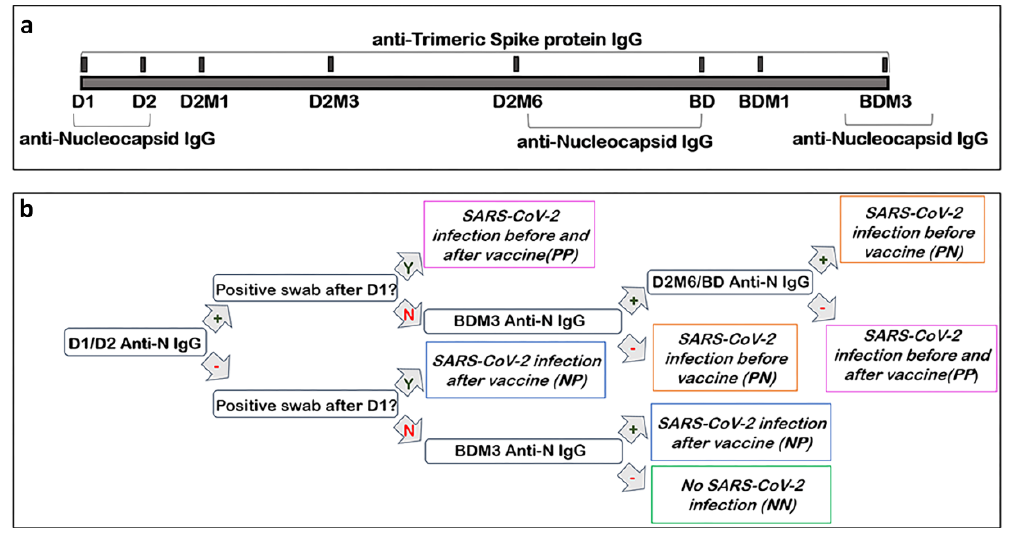
Figure 1. Illustration of study design: ( a ) timeline and methods; and ( b ) schematic representation of the methods used to determine the SARS-CoV-2 infection group allocation. D1, dose 1; D2, dose 2; D2M1, 1 month after dose 2; D2M3, 3 months after dose 2; D2M6, 6 months after dose 2; BD, booster dose; BDM1, 1 month after booster dose; BDM3, 3 months after booster dose; SARS-CoV-2, severe acute respiratory syndrome-coronavirus-2; anti-N IgG, anti-nucleocapsid IgG; NN, never-infected subjects; PN, subjects infected before the beginning of the vaccination cycle; NP, individuals infected during the vaccination campaign; and PP, individuals infected before and after the vaccination campaign.